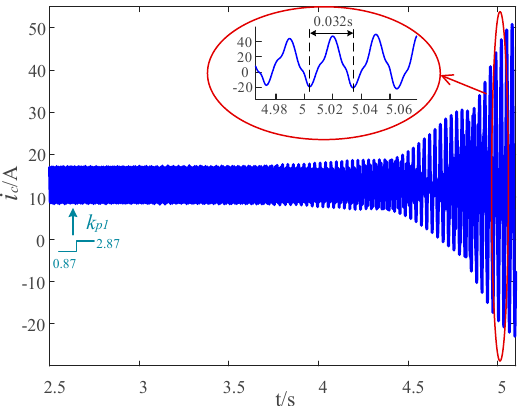
= 2.87 while other parameters remain unchanged.